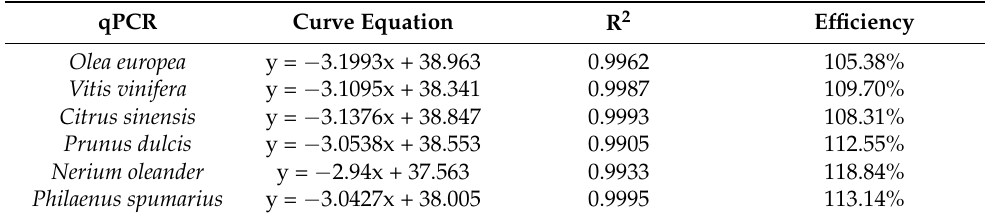
Table 2. Equation of standard curves, R 2 value, and efficiency generated by qPCR for the six matrices spiked with Xfp bacterial